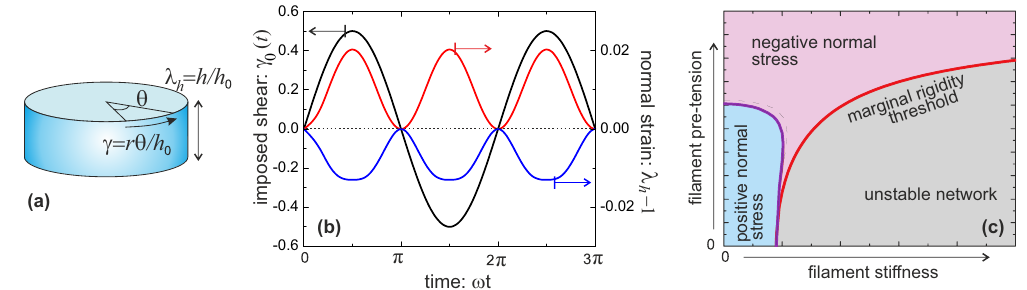
Figure 11. ( a ) Cylindric material under oscillating shear deformation; ( b ) The relation between oscillating shear strain γ at the outer surface of the cylinder (black curve) and the normal strain λ h − 1 for a flexible network (red curve) with c = 0.1, x = 0.1, and a stiff network (blue curve) with c = 0.3, x = 0.6; ( c ) Phase diagram of the network of different stiffness and filament pre-tension, showing the regions of positive/negative Poynting effect (normal stress) and also the boundary of network stability discussed